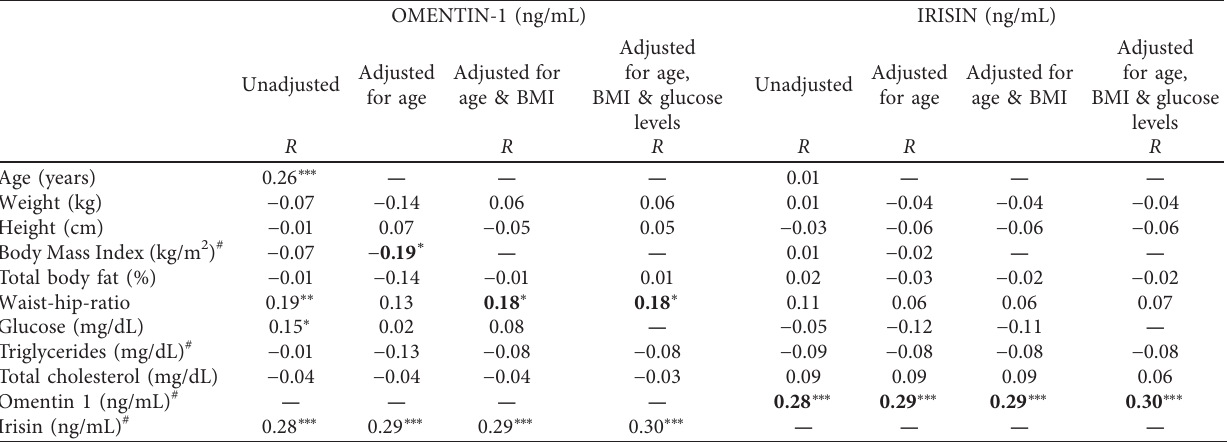
Table 2: Bivariate correlation matrices. Unadjusted Pearson’s or Spearman’s coefficients and partial correlation coefficient after sequential adjustment for age, Body Mass Index (BMI), and glucose levels in the overall study group.